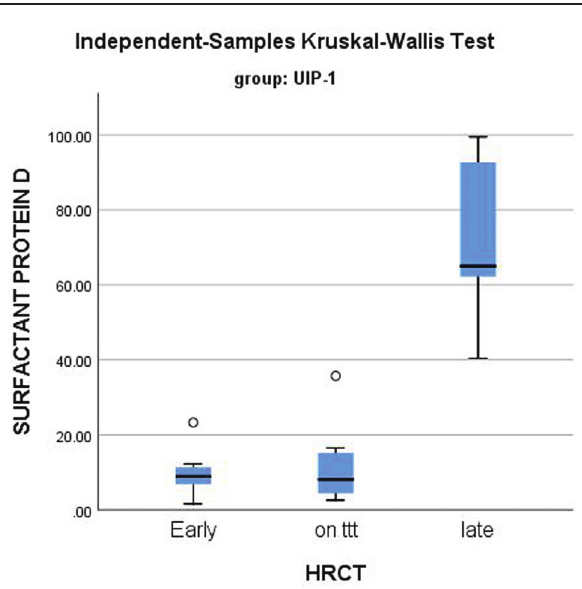
The serum level of surfactant protein-D in the three different sub- groups of UIP patients. UIP, usual interstitial pneumonia.